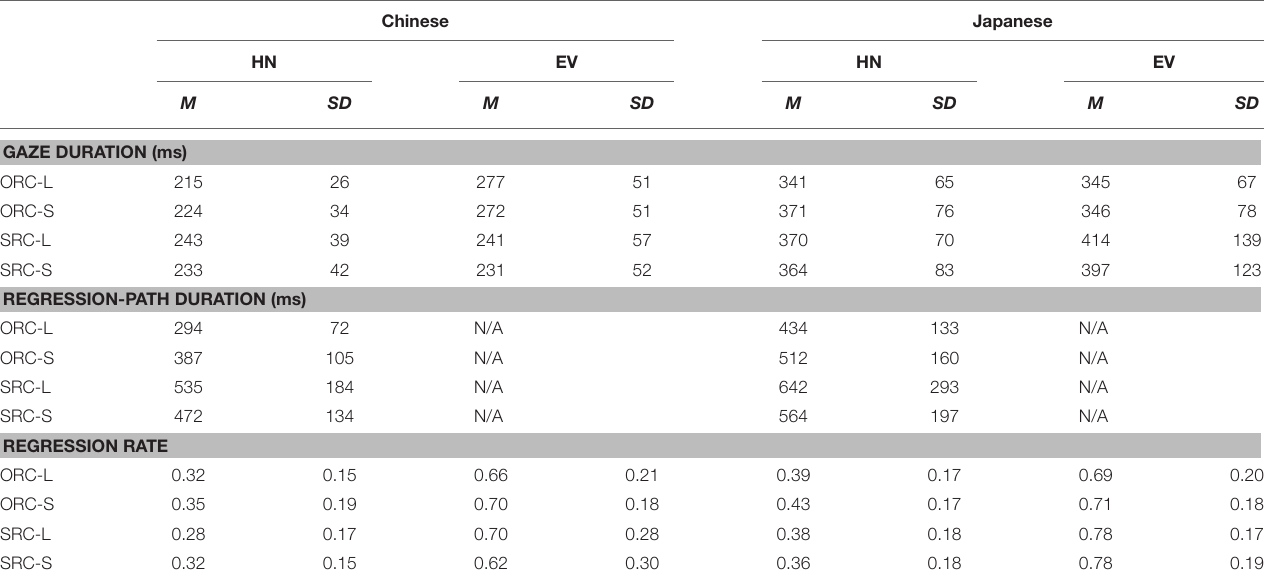
TABLE 4 | Data for eye-movement indices for each critical